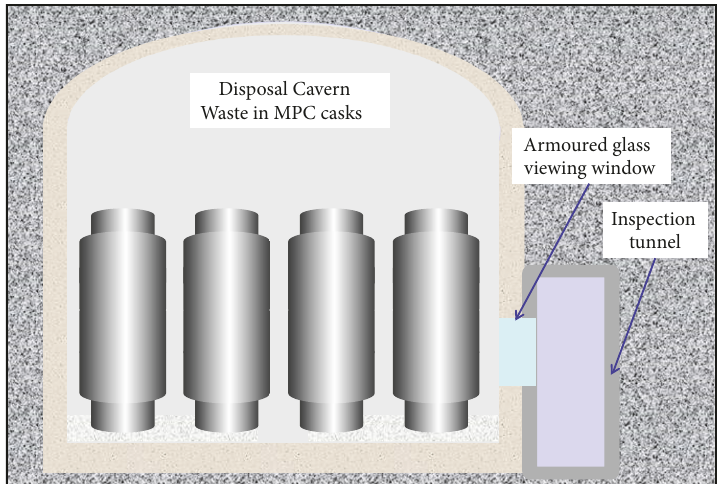
Figure 1: Variant of CARE concept allowing inspection during storage